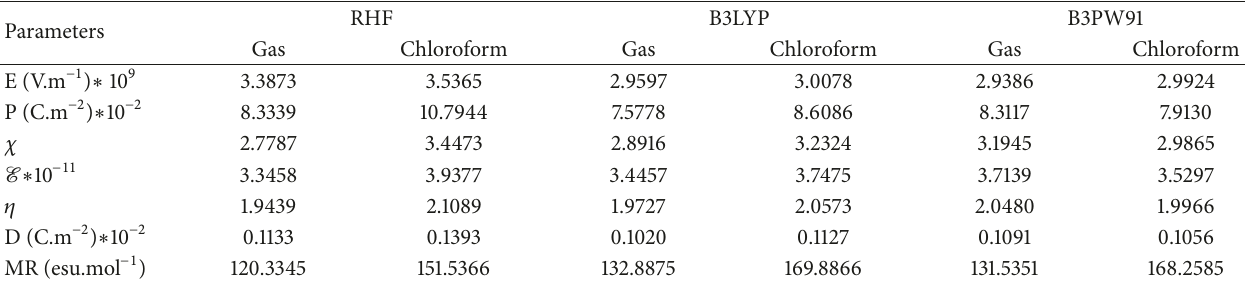
Table 6: Calculated values of polarization density (P), average electric field (E), electric susceptibility ( 𝜒 ), refractive index ( 𝜂 ), dielectric constant ( E ), magnitude of the displacement (D), and molar refractivity (MR) of Rubescin E molecule obtained at the RHF, B3LYP, and B3PW91 levels with the 6-311++G(d,p) basis